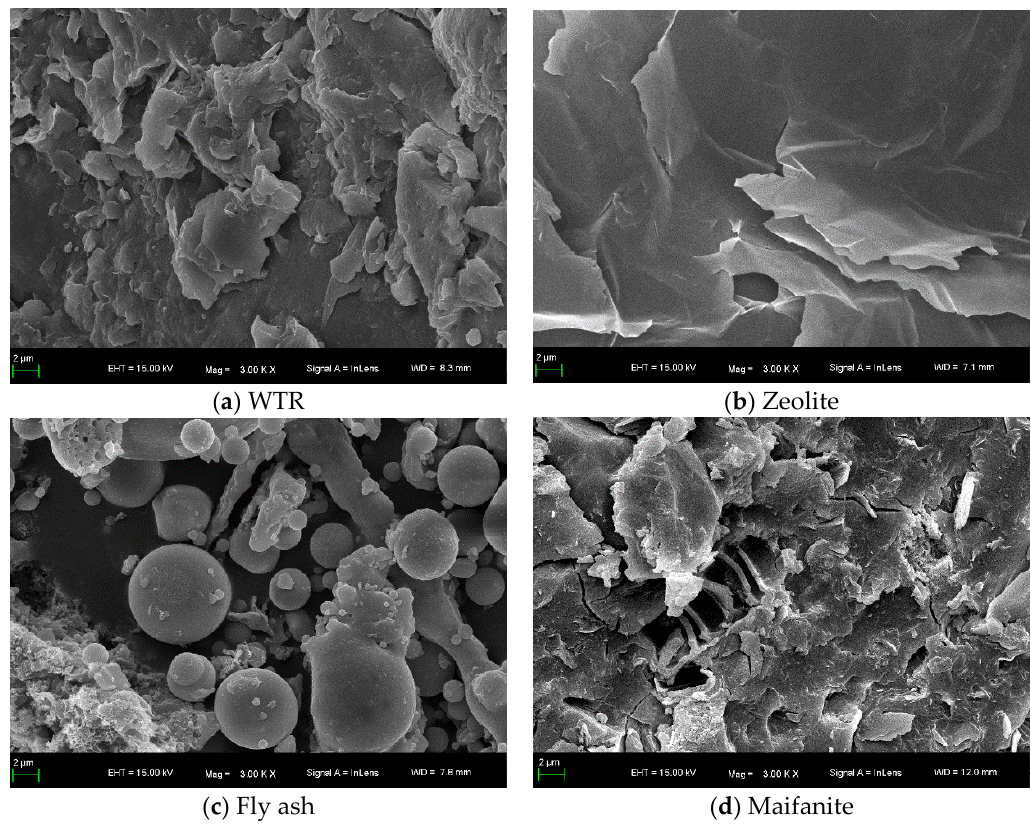
Figure 2. SEM images of ( a ) WTR, ( b ) Zeolite, ( c ) Fly ash, and ( d ) Maifanite. Table 3. Media characteristics.